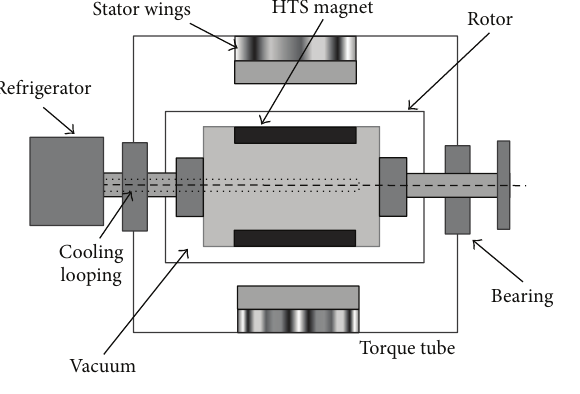
Figure 4: The basic structure of HTSG.